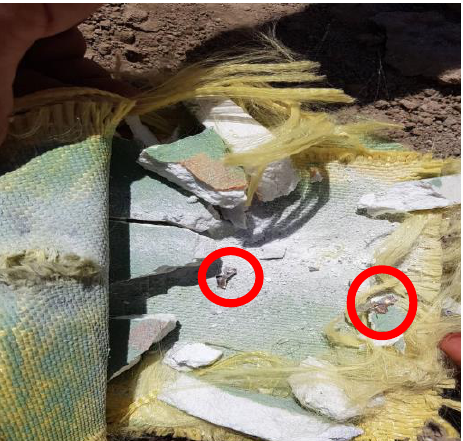
Fig.7: The ballistic test by AK47 with bullets of 7.62*51